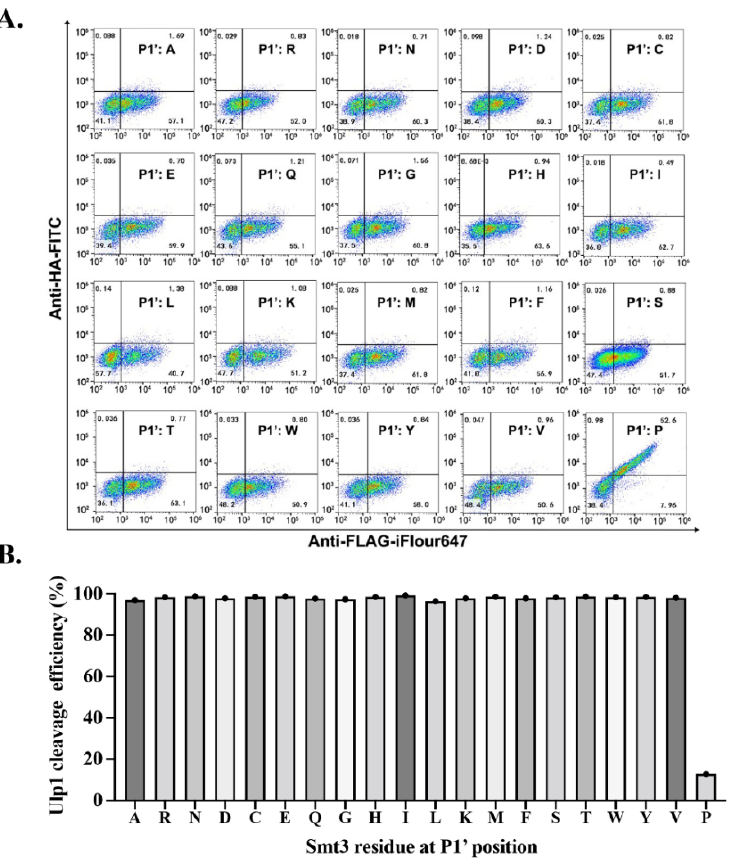
Figure 2. Mapping residue specificity of Ulp1 at Smt3 P1’ position. Ulp1-GAL1-GAL10-Aga2-FLAG- Smt3GG ↓ X-HA (X is an arbitrary amino) cassettes are, respectively, expressed in YESS–PSSC system, followed by direct flow cytometry analysis. ( A ) Representative flow cytometry results. ( B ) Data of A are presented as average cleavage efficiency ( n = 3 independent experiments).